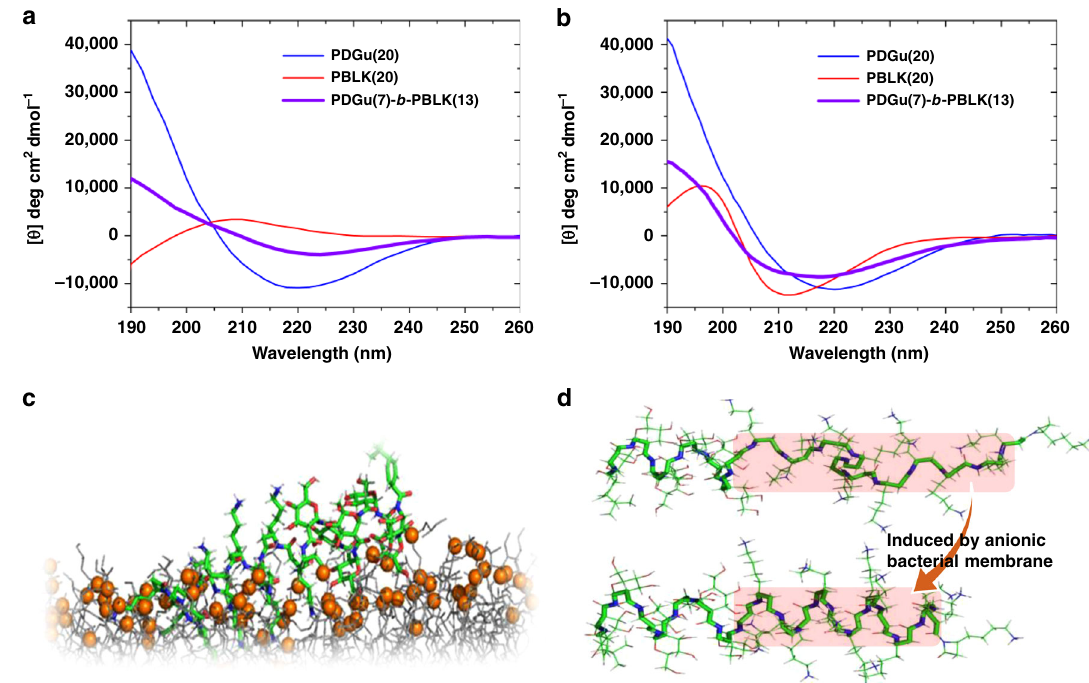
Fig. 3 Bacterial-induced secondary structure transition of PDGu(7)- b -PBLK(13) . a , b Molar ellipticity [ θ ] CD spectra of PDGu(20) (blue), PBLK(20) (red), and PDGu(7)- b -PBLK(13) (purple) in DI ( a ) and in the presence of anionic POPG liposomes ( b ). c A snapshot of computer simulation of PDGu(7)- b -PBLK (13) binding to anionic bacterial membrane. The membrane model is colored as gray lines with the head groups of the lipid molecules shown as orange spheres. PDGu(7)- b -PBLK(13) is shown as a stick model, its carbon, oxygen, nitrogen, and hydrogen atoms are colored as green, red, blue, and white, respectively. d Computer simulation of transition from helix – coil in solution to helix – helix induced by anionic